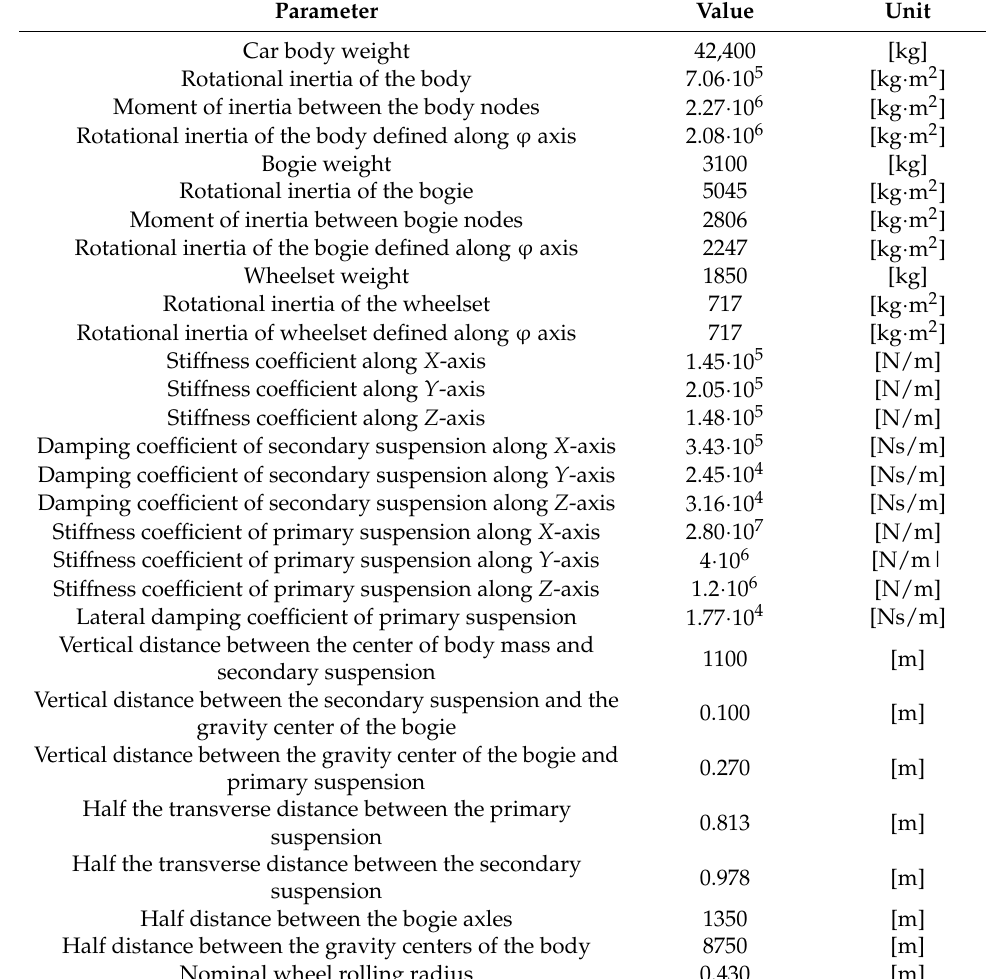
Table 1. Parameters of the rail vehicle used in computer